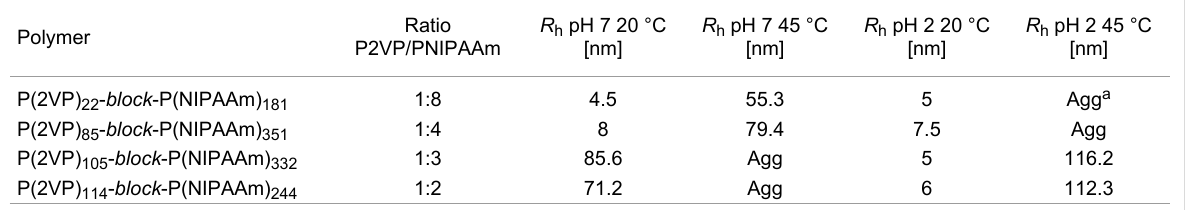
Table 3: Dynamic light scattering characterization of bi-responsive P2VP- block -PNIPAAm copolymers in aqueous solution.